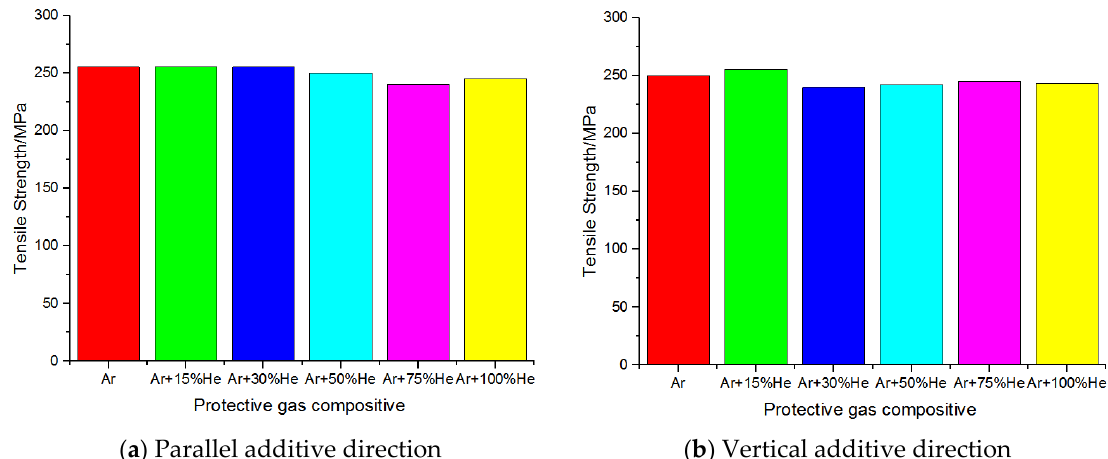
Figure 11. Tensile strength of samples under different protective gas compositions.